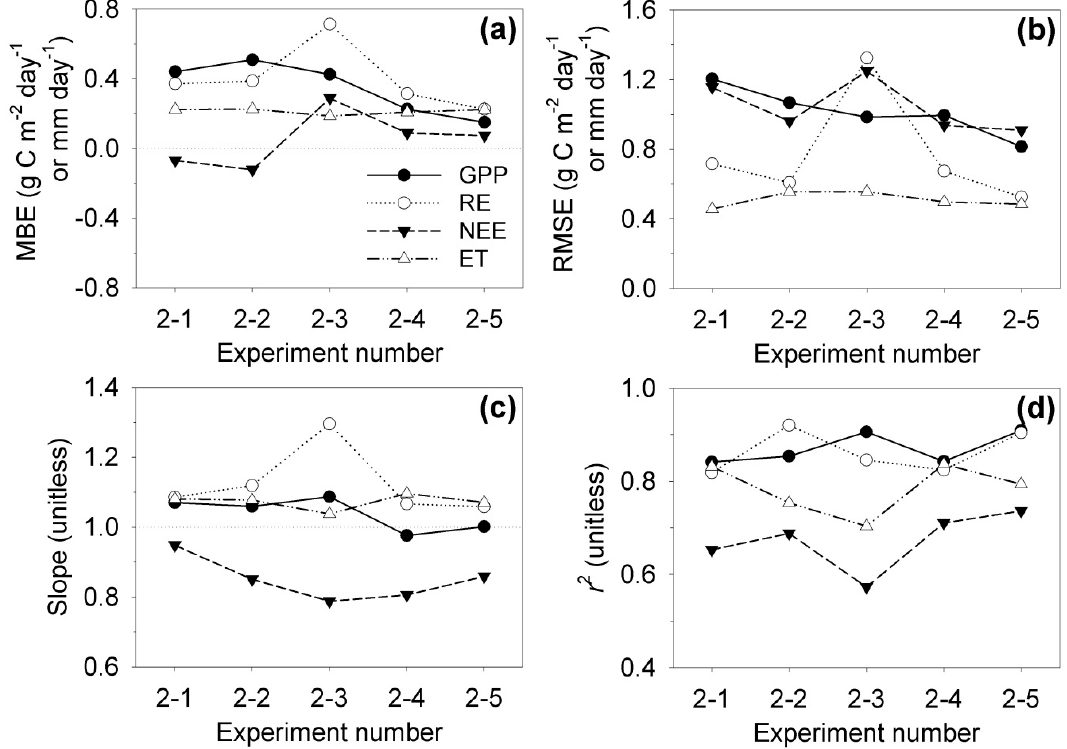
Figure 5. Statistical parameters for error assessment of Experiments 2-1, 2-2, 2-3, 2-4, and 2-5. MBE ( a ) and RMSE ( b ) indicate mean bias error and root-mean-square error, respectively. Slope ( c ) and r 2 ( d ) obtained from linear regression analysis.